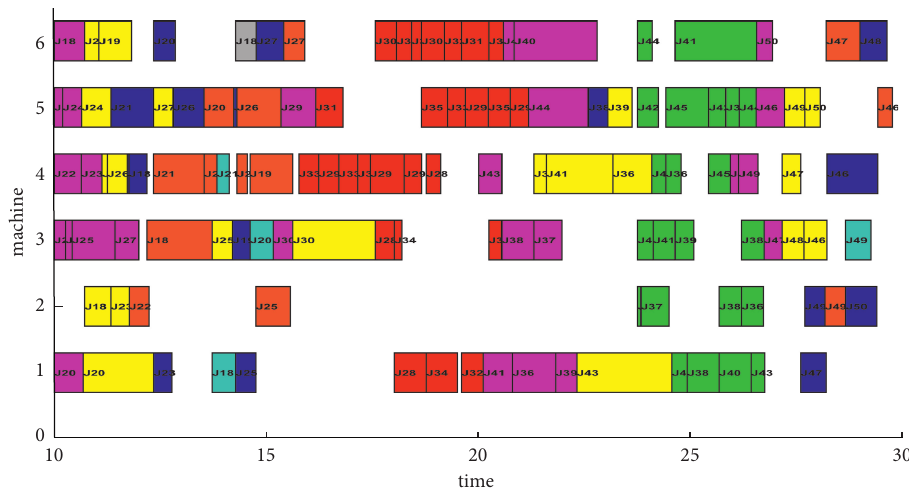
Figure 8: Gantt chart of t � 10–30 scheduling scheme.